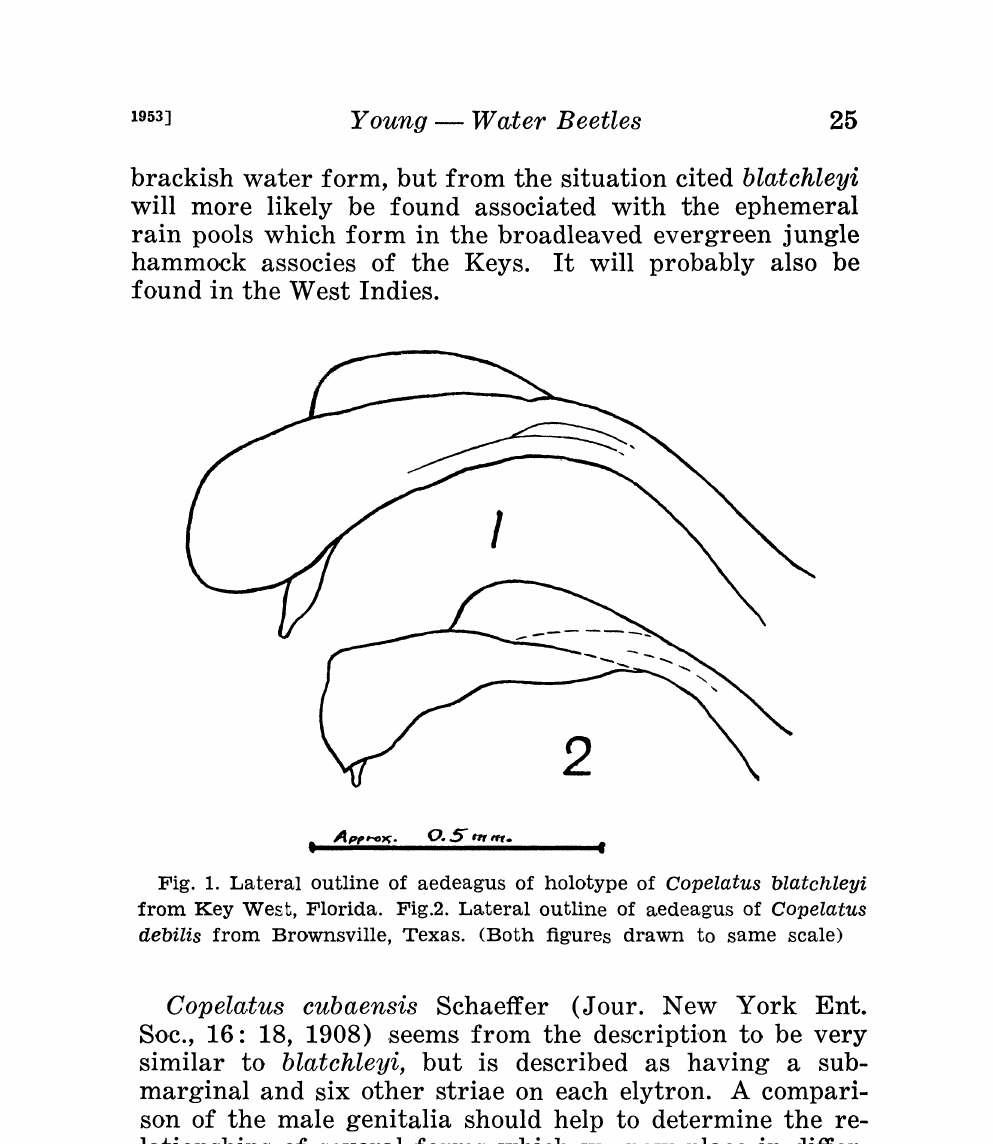
Fig. 1. Lateral outline of aedeagus of holotype of Copelatus blatchleyi from Key West, Florida. Fig.2. Lateral outline of uedeagus of Copelatus clebilis from Brownsville, Texas. (Both figures drawn to same scale) Copelatus cubaensis Schaeffer (Jour. New York